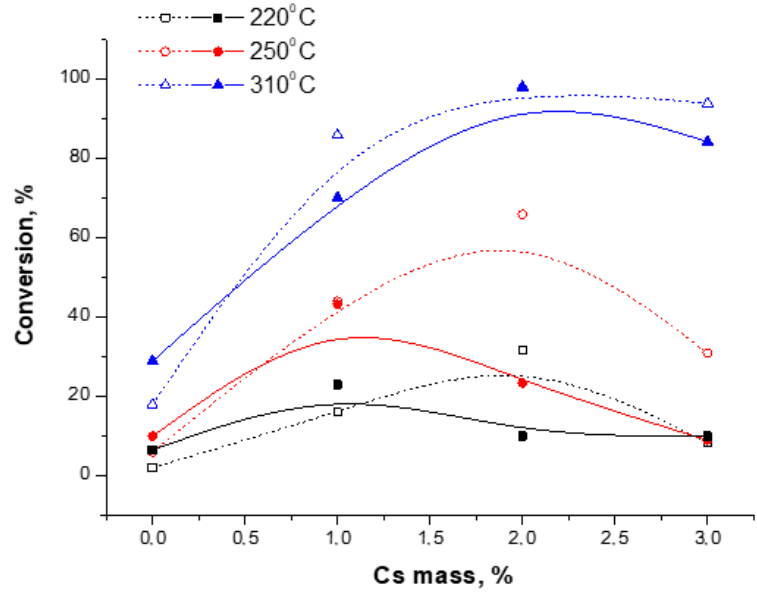
Figure 3. Influence of the mass content of Cs cations on N 2 O conversion in the temperature range 220–310 ◦ C. Samples: Ni 0.5 Co 2.5 O 4 (dotted) and Mg 0.5 Co 2.5 O 4 (solid). It was shown that at low temperatures of 220–250 ◦ C, the optimal content is 1 wt% Cs for Mg 0.5 Co 2.5 O 4 and 2 wt% Cs for Ni 0.5 Co 2.5 O 4 . The authors of [32] estimated the optimal content of potassium cations for the Co 2.6 Zn 0.4 O 4 catalyst in the range of 2–6 atoms of K/nm 2 . According to [18,33], for the Co 3 O 4 catalyst the optimal amount of Cs is 2–3 at. Cs/nm 2 (i.e., ~1 wt% Cs). In our case, the amount of the alkaline promoter does